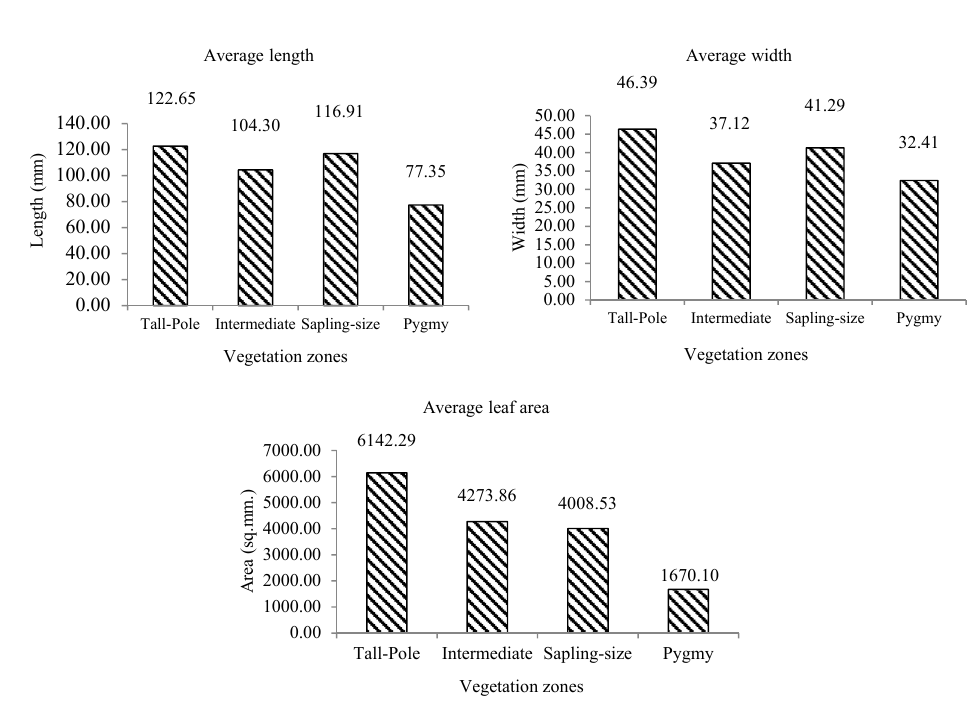
Fig. 2: Average leaf size indices of the various vegetation zones